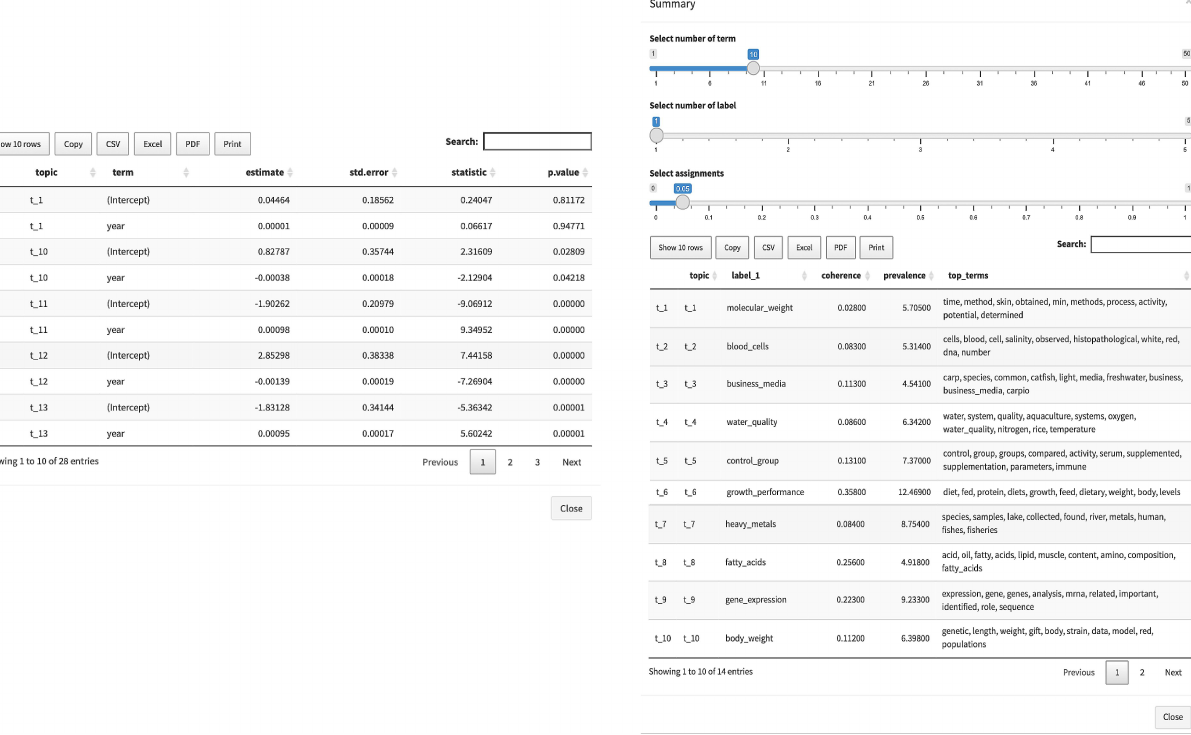
Figure 10. Output tabular of the model Trends ( left ) summary ( right